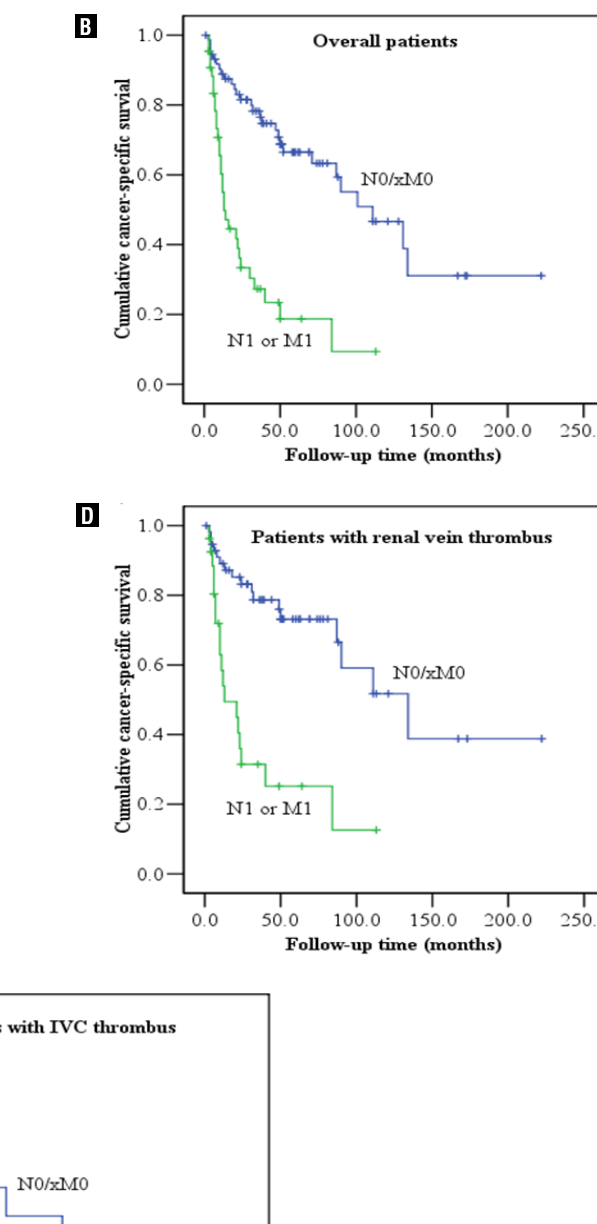
Figure 1 - Estimated cancer-specific survival (CSS) using Kaplan-Meier curve according to (a) thrombus level (renal vein vs. IVC) in overall patients; (b) presence or absence of metastasis (pN0/xM0 vs. pN1 or M1) in overall patients; (c) thrombus level (renal vein vs. IVC) in non-metastatic (pN0/xM0) patients; (d) presence or absence of metastasis (pN0/xM0 vs. pN1 or M1) in patients with renal vein thrombus only; (e) presence or absence of metastasis (pN0/xM0 vs. pN1 or M1) in patients with IVC thrombus. IVC = inferior vena